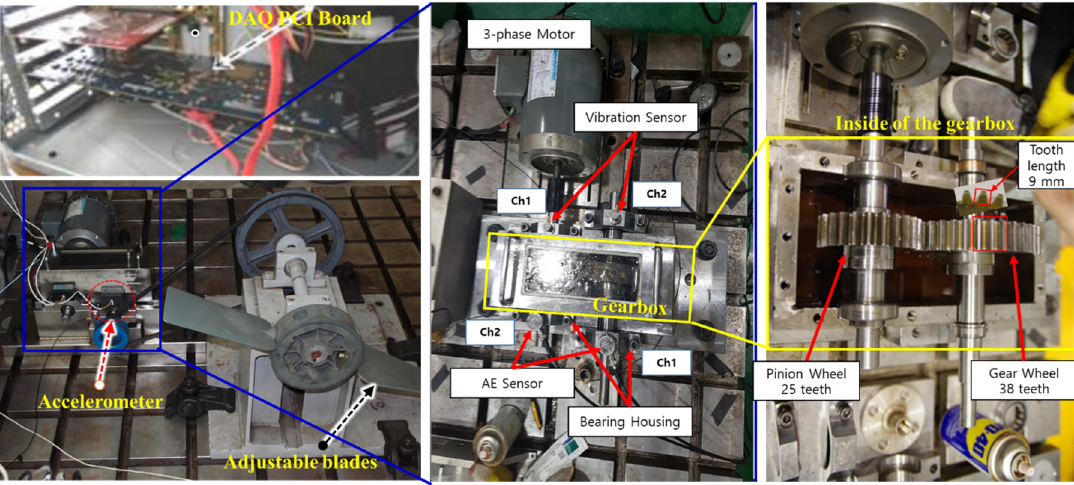
Figure 7. Gearbox experimental testbed. Table 1. Specifications of the sensors and data acquisition system.